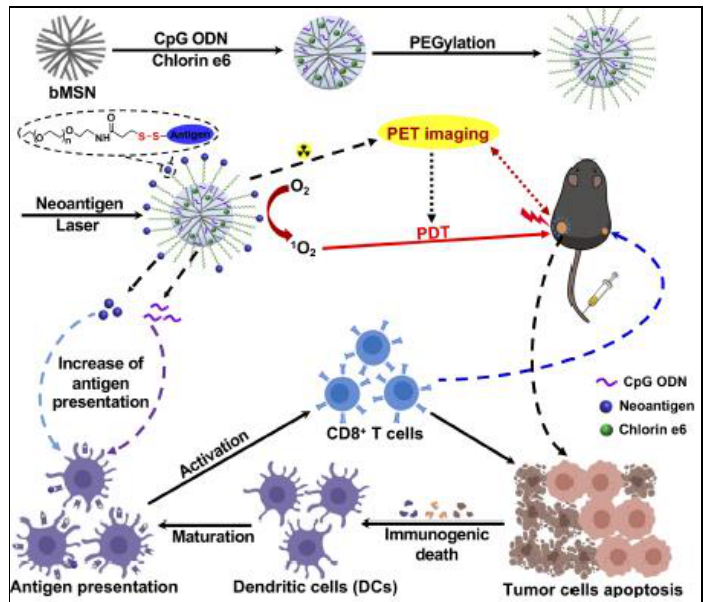
Figure 4. Schematic illustration of PET-guided PDT MSN used by Xu et al., 2019 [90]. Reprinted with permission from Xu et al., 2019. Copyright (2019) American Chemical Society.